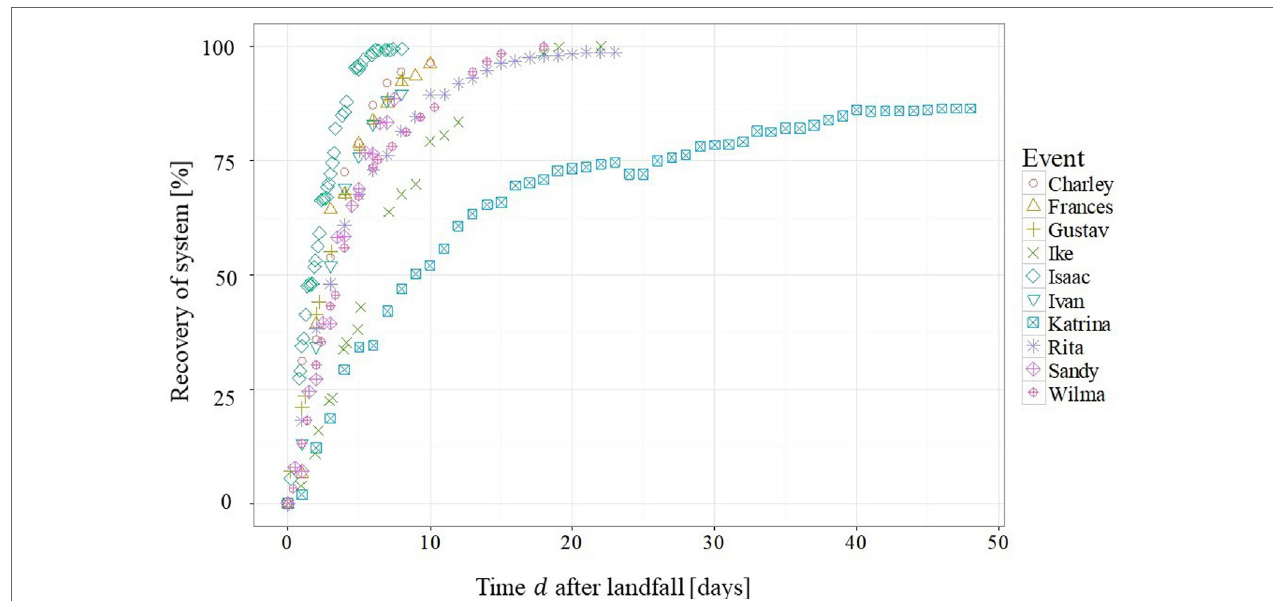
FigUre 8 | The cumulative probability function for the time to recovery for the state level hurricane data.